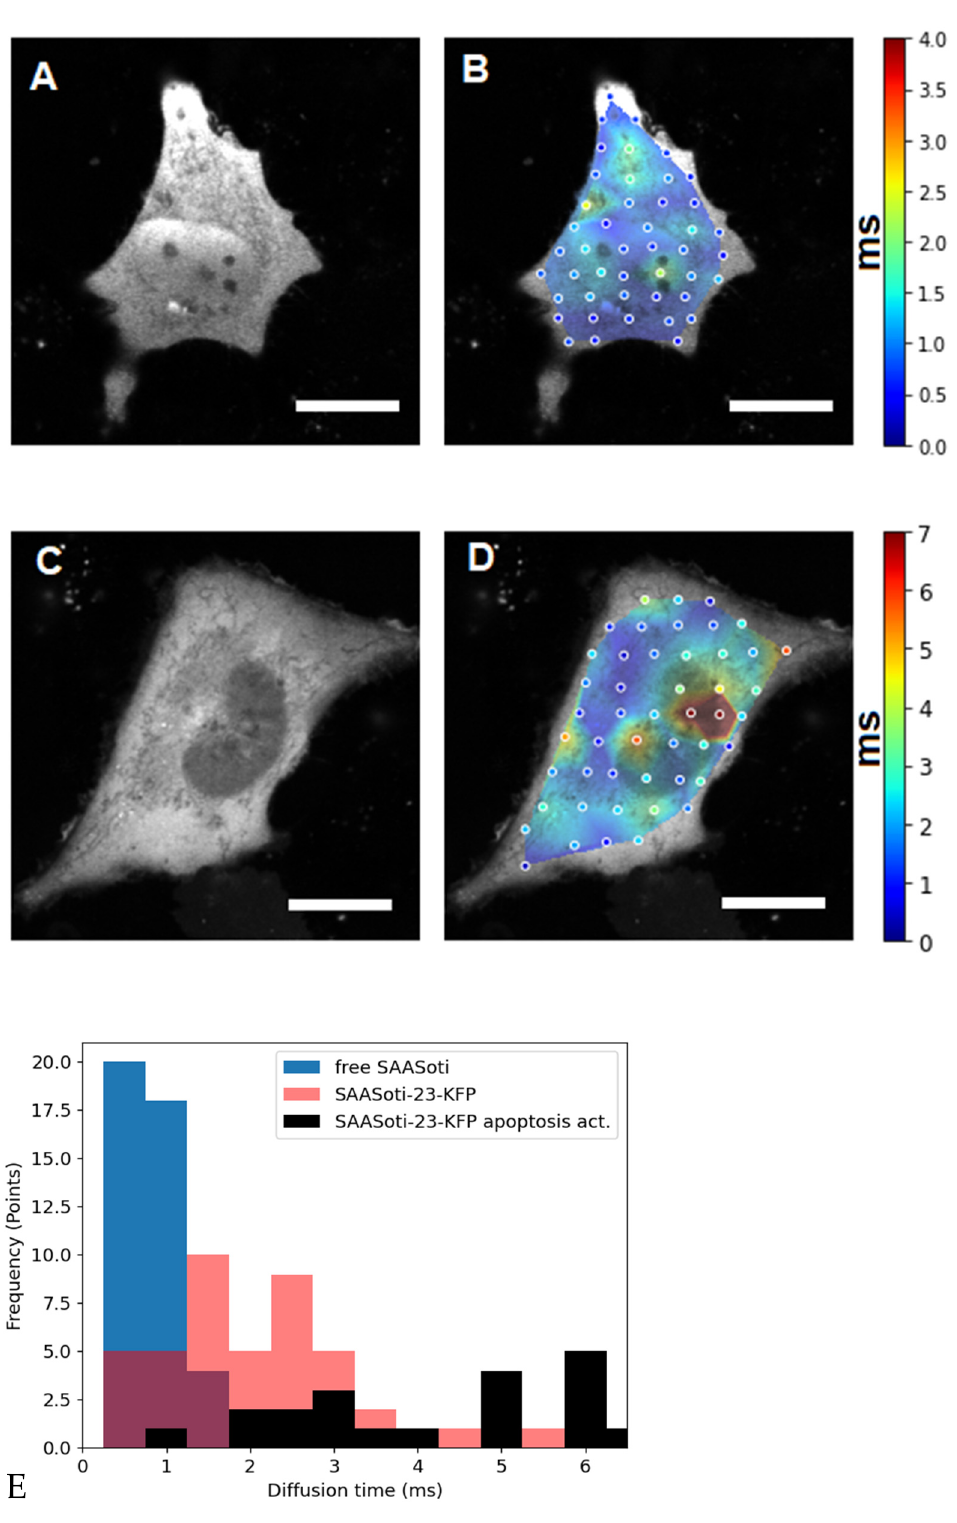
Figure 2. The left panels ( A , C ) are fluorescence images of HeLa cells transfected with ( A ) free SAASoti and ( C ) SAASoti-23-KFP in the red channel. The right panels ( B , D ) are images of the diffusion time distributions of the SAASoti red form in the cell. The color corresponds to the value of the diffusion time according to the scale to the right of the images in milliseconds. Images are 80 × 80 microns in size. ( E ) Points diagram distribution from (0.5 ms bining) for free SAASOti ( B ), SAASOti-23-KFP ( D ), and SAASOti-23-KFP 2 h after induction of apoptosis by staurosporine (Figure 3D). Scale bar = 20 µ m .